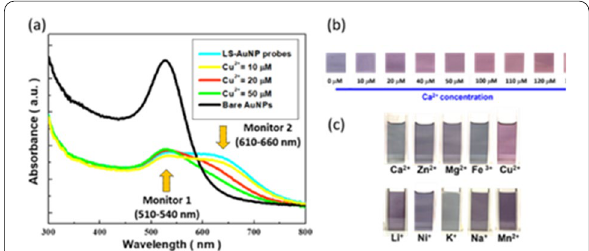
Fig. 2 a Light‑absorption spectra of various LS‑AuNP probes. Colorimetric examinations for b detecting Cu 2 + ions and c various metal ions with fixed 50 μM in